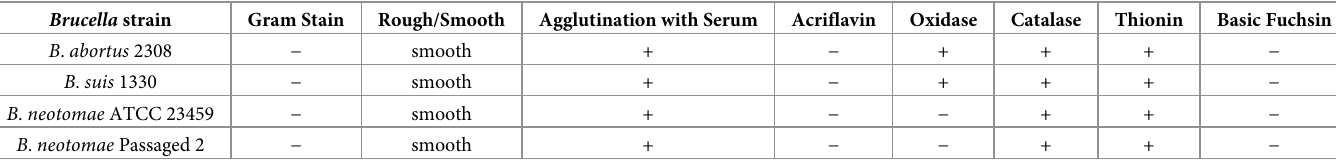
Table 1. Brucella presumptive